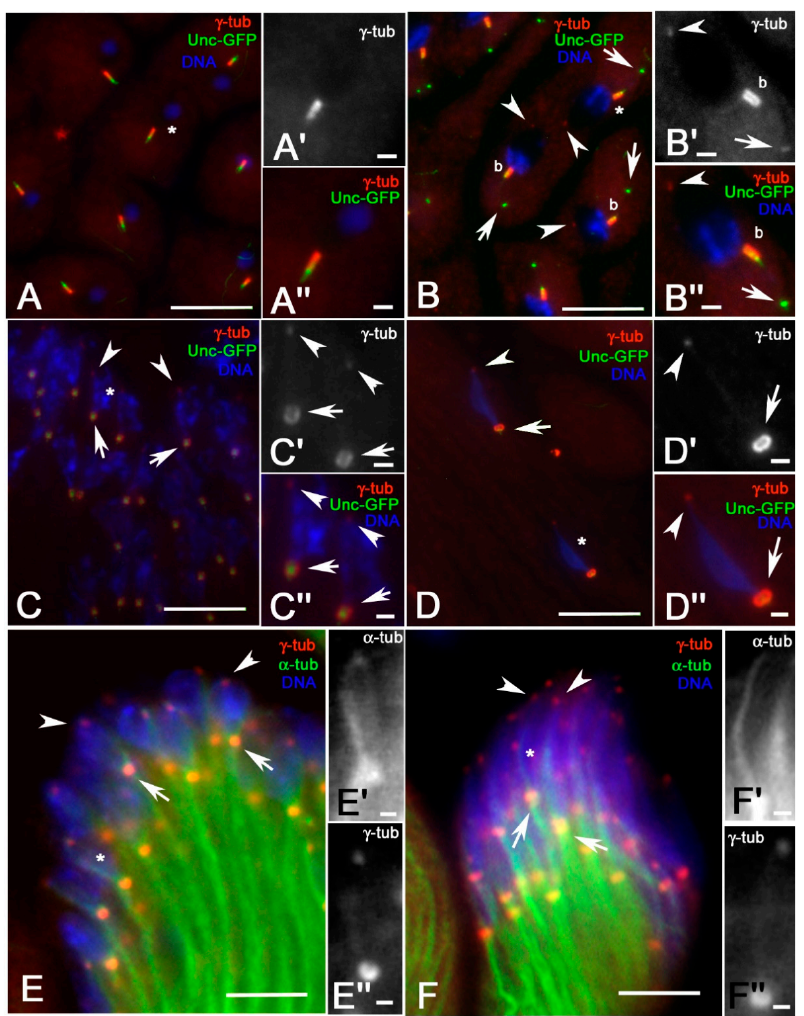
Figure 5. γ -tubulin localization during early spermiogenesis of pupal testes. ( A – A” ) Onion stage spermatids: γ -tubulin colocalizes with the basal body. ( B – B” ) Young elongating spermatids: γ -tubulin is localized in a small spot (arrowhead) on the apical side of the nucleus, on the basal body (b) and on the ring centriole (arrows). Spermatids at the leaf ( C – C” ) and canoe ( D – D” ) stages: γ -tubulin forms a circular cluster around the basal body (arrows) and a small spot in the apical region of the nucleus (arrowheads). Counterstain with α -tubulin of leaf ( E – E” ) and canoe ( F – F” ) stage spermatids shows that γ -tubulin is localized at the base (arrows) and distal ends (arrowheads) of the perinuclear bundles. High magnification images in the right insets are from spermatids marked by asterisks. Scale bars: ( A – F ), 7 µ m; ( A’ – F’ , A” – F” ), 0.5 µ